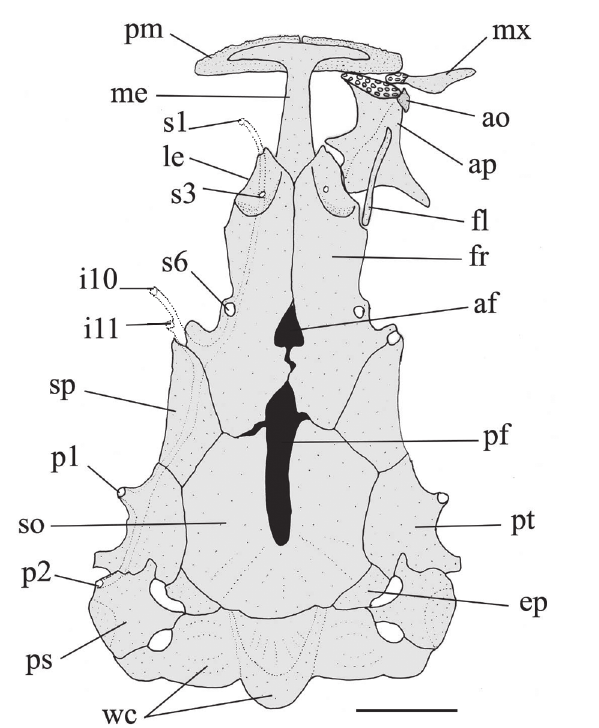
Fig. 3. Neurocranium and Weberian apparatus of Trichomycterus payaya , UFBA 5286, paratype, 31.4 mm SL. Ventral view. Abbreviations: ap, autopalatine; ep, epioccipital; fl, fronto-lacrimal tendon bone; fr, frontal; gf, foramen for anterior branch of glossopharyngeal nerve; i10, i11, infraorbital sensory pores 10 to 11; le, lateral ethmoid; me, mesethmoid; mx, maxilla; of, optic foramen; os, orbitosphenoid; pa, parasphenoid; pm, premaxilla; ps, posttemporosupracleitrum; pt, pterotic; sp, sphenotic; tf, foramina for trigeminofacial nerve branches; vf, foramen for vagus nerve; vo, vomer; wc, weberian complex and capsule. Scale bar = 1